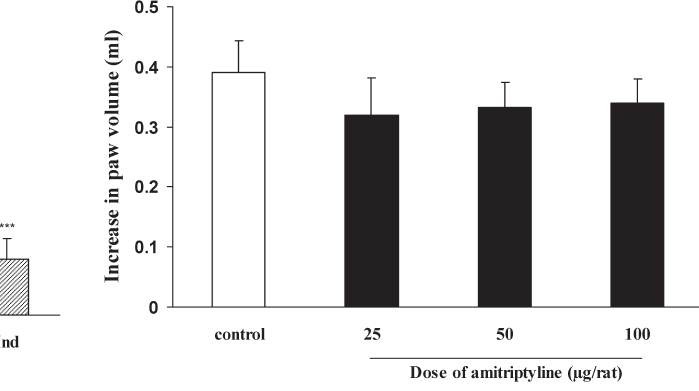
Figure 1 - Effect of i.p. injection of amitriptyline on carrageenan- induced paw edema in rats. Amitriptyline (20, 40 and 80 mg kg -1 ), indomethacin (10 mg kg -1 ) and the vehicle were administrated 30 min prior to carrageenan (1%) injection, and the rats were evaluated for paw edema 4 h post-carrageenan injection. The values represent the mean variation in the paw volume ¡ S.D. (n=6, *** P , 0.001). Ind: indomethacin.